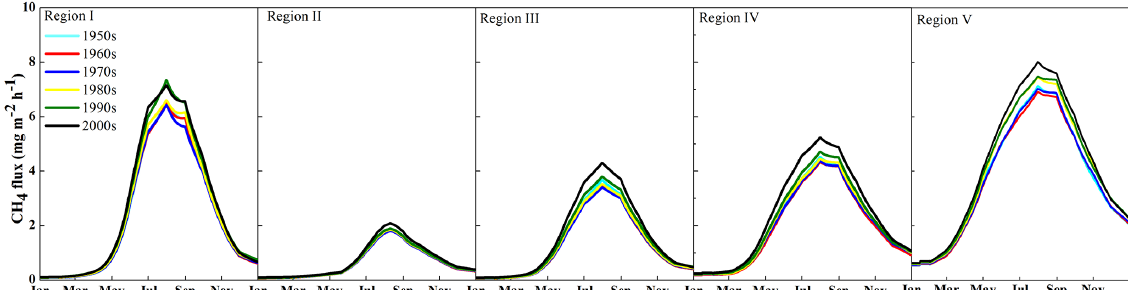
Figure 3. Seasonal variations in methane fluxes in the five regions.